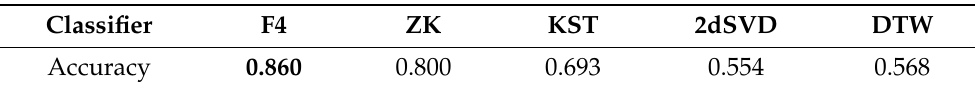
Figure 7. ECG of a patient suffering from MI (top panel) and of a healthy volunteer (bottom panel). Table 7. Average accuracies of the five classifiers in the ECG database. The best result is shown in